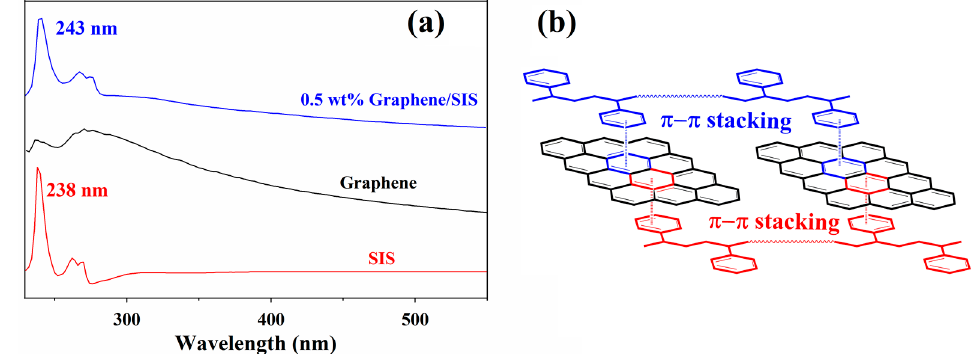
Figure 2. ( a ) UV absorption spectra and ( b ) π – π stacking interactions between graphene and SIS.